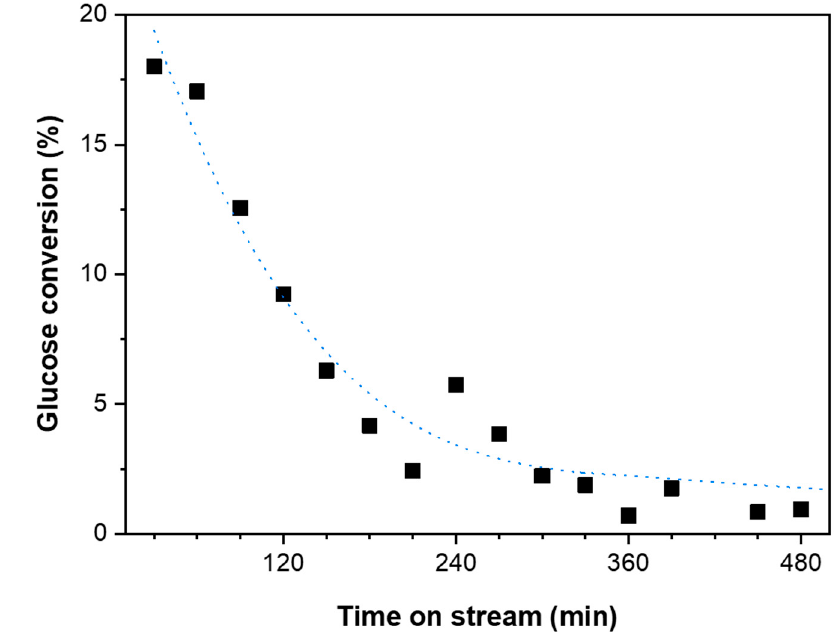
Figure 8. Catalytic activity of ZIF-8 in a continuous flow reactor at weight hourly space velocity (WHSV) of 10.5 h − 1 .